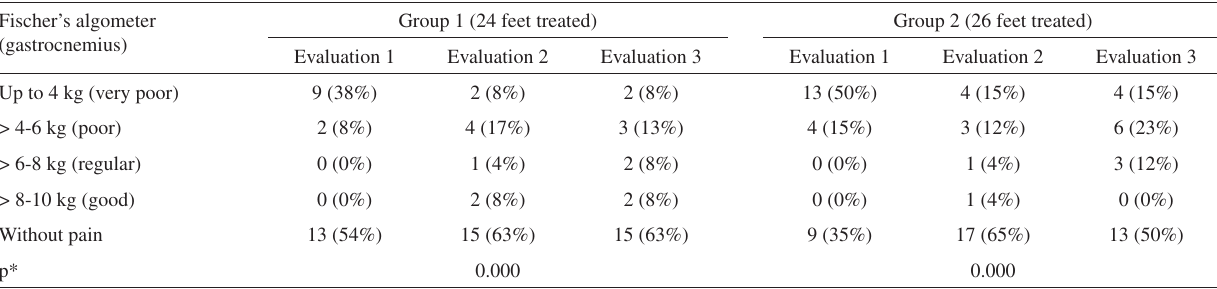
Table 8 – Frequency and percentage of patients who had stopped using analgesics three months after treatment Stopped using analgesics three months after treatment